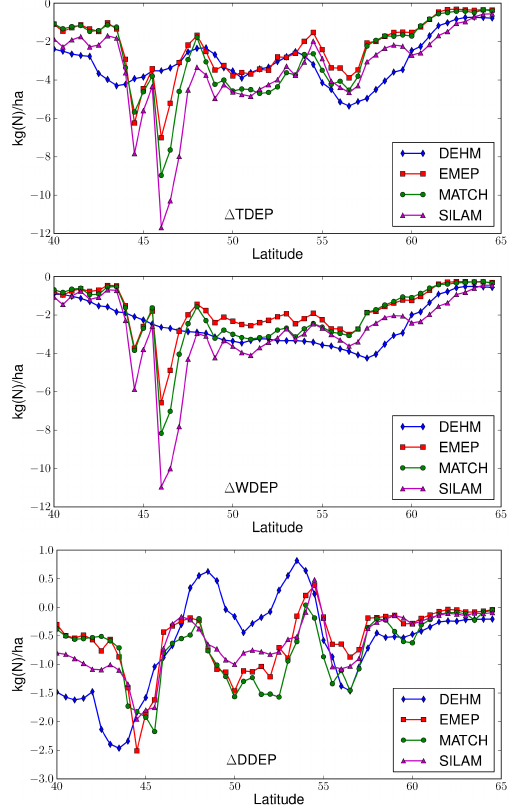
Figure 9. Calculated changes in total, wet and dry deposition of Nr, future case (E50-M5-BC3) minus base case (E05-M00-BC1). Same transect as Fig. 8.